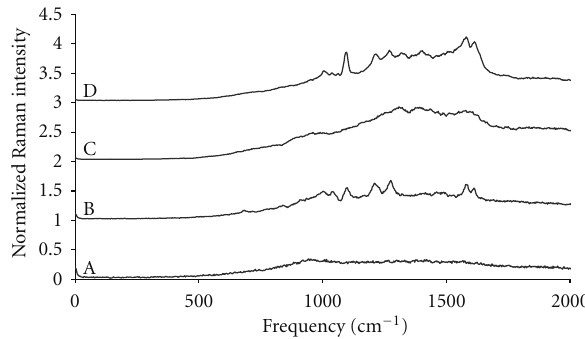
Figure 3: Normalized and o ff set Raman spectra during in vitro sensor development. (A) Raman spectrum of Au@Ag colloids. (B) Raman spectrum of 4-MPy adherent to Au@Ag colloids. (C) Raman spectrum of DNP adherent to Au@Ag colloids. (D) Raman spectrum of targeted nanosensor with DNP and 4-MPy ligands. Y axis is arbitrary intensity units. Reprinted with permission from Nowak-Lovato et al. [11] (copyright 2009 Society for Applied